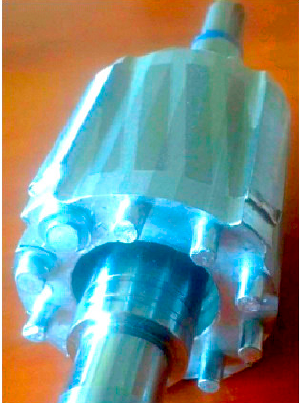
Figure 5. The manufactured rotor with milled slots.